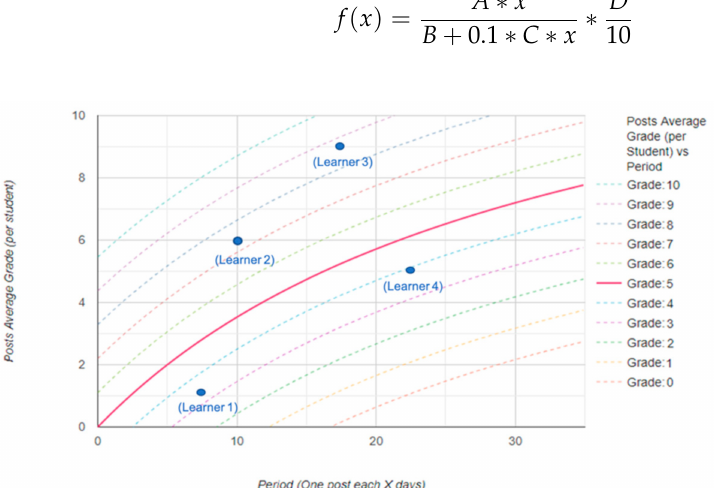
Figure 2. Chart representing f ( x ) (Grade 5 points, middle of the range from 0 to 10 points) plus some other curves calculated through the Euclidean distance to f ( x ) in the range from 0 to 10 points. This way it is possible to assign a score to the points P(x, y) that represent each learner from their distance to f ( x